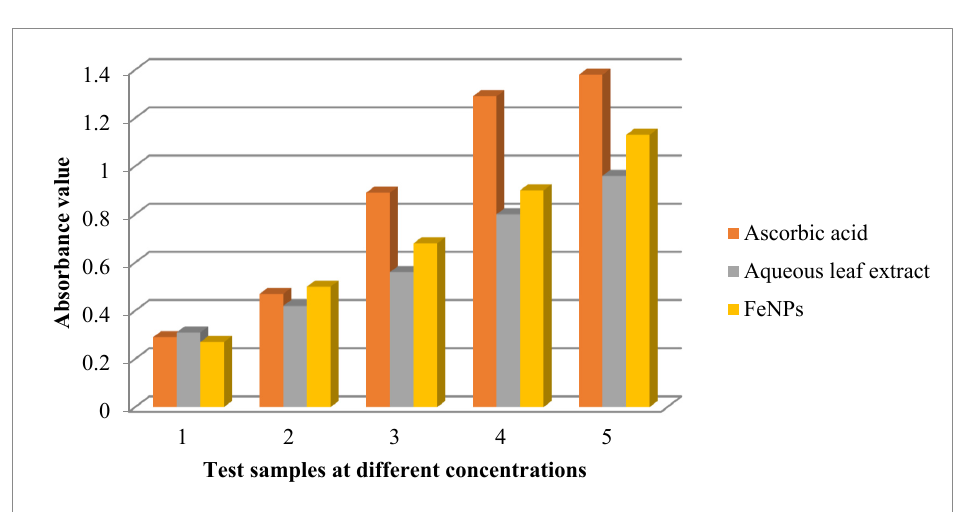
Figure 11. PM assay of aqueous leaf extract of V. leucoxylon and its synthesized iron nanoparticles. Inflammation is the immunological reaction to a specific event, whereas infection is